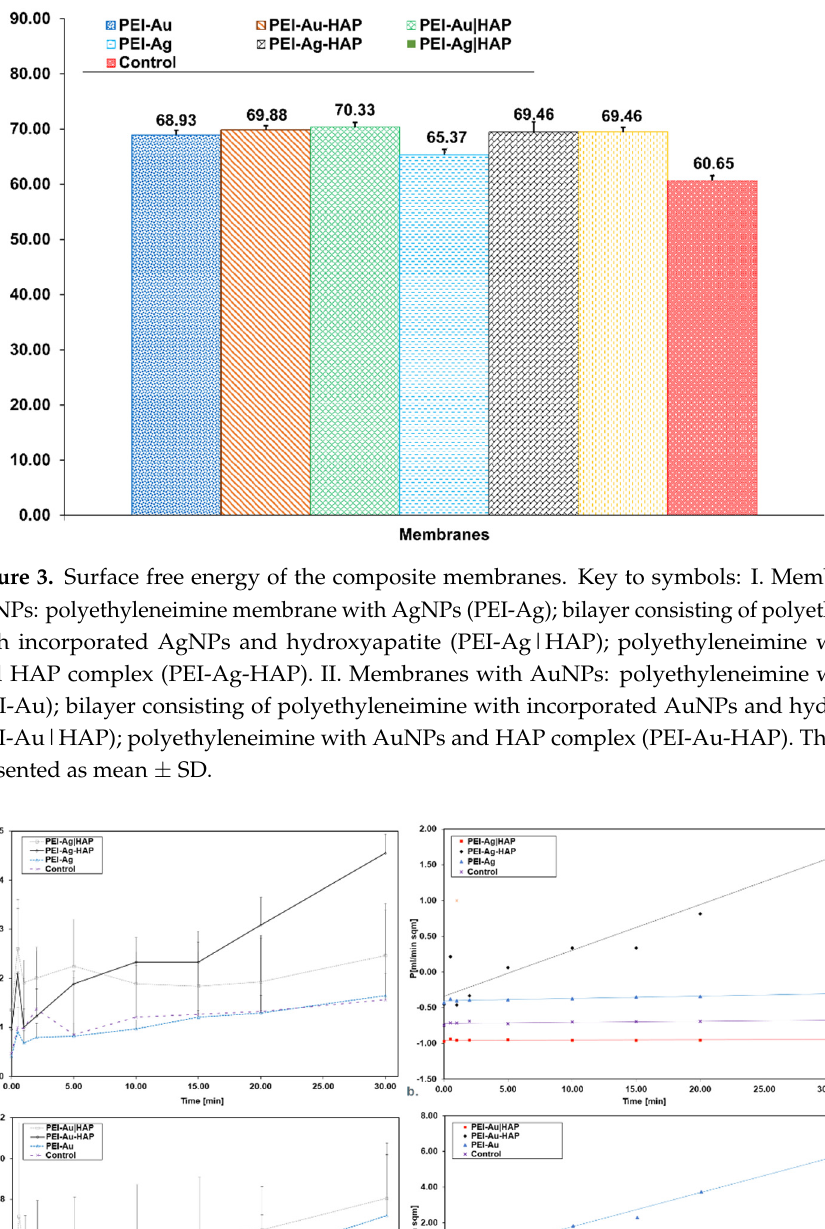
Figure 5. Dextran 150 concentration in the function of time during permeation through the membrane scaffolds containing silver ( a ) or gold ( c ) nanoparticles. Membrane permeability and time product during particular time intervals permeation for Dextran 150 through the membrane scaffolds containing silver ( b ) or gold ( d ) nanoparticles. Key to symbols: PEI-Ag: polyethyleneimine with AgNPs; PEI-Ag|HAP: polyethyleneimine with AgNPs—hydroxyapatite; PEI-Ag-HAP: polyethyleneimine with AgNPs and HAP complex. PEI-Au: polyethyleneimine with AuNPs; PEI-Au|HAP: polyethyleneimine with AuNPs—hydroxyapatite; PEI-Au-HAP: polyethyleneimine with AuNPs and HAP complex. The values are presented as mean ±SD.